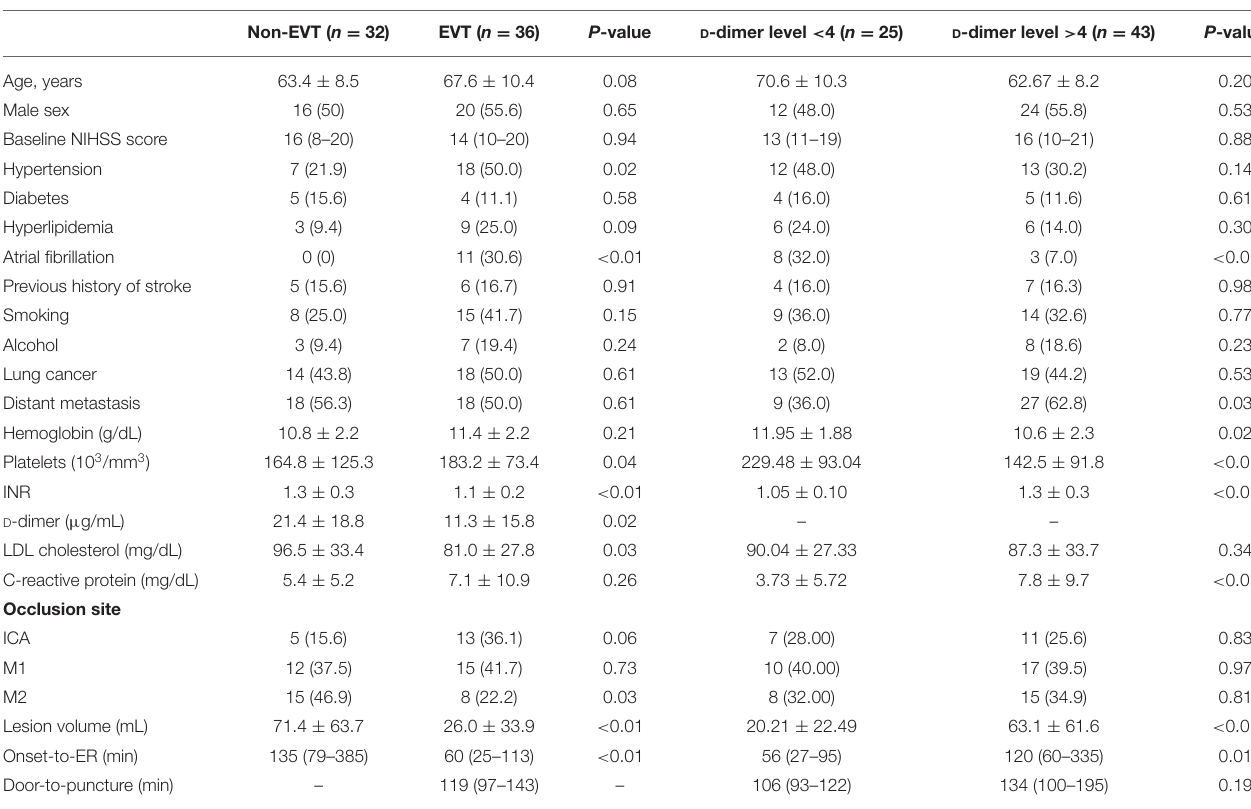
TABLE 1 | Patients’ baseline characteristics.